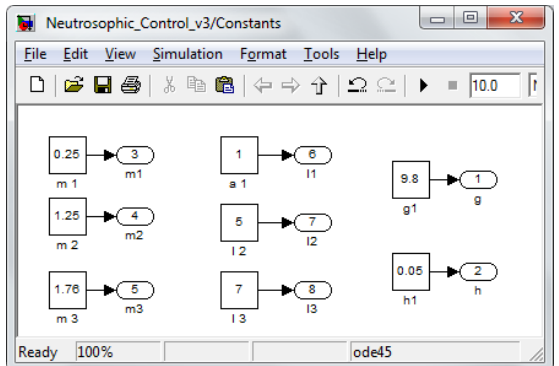
Figure 11. Foot reference signals.